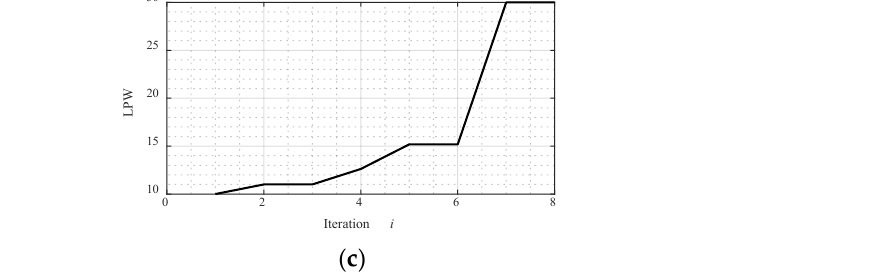
Figure 11. Numerical results obtained for Antenna V using the proposed algorithm incorporating multi-fidelity model management and adaptive penalty coefficients: ( a ) reflection responses, ( b ) axial ratio responses, ( c ) evolution of the model fidelity. The horizontal lines represent the design specifications.